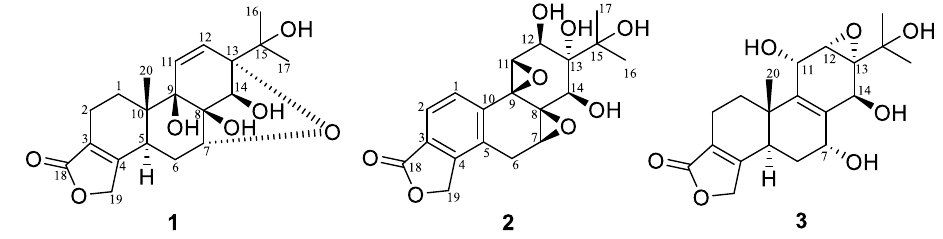
Figure 1. The structures of compounds 1 – 3 .